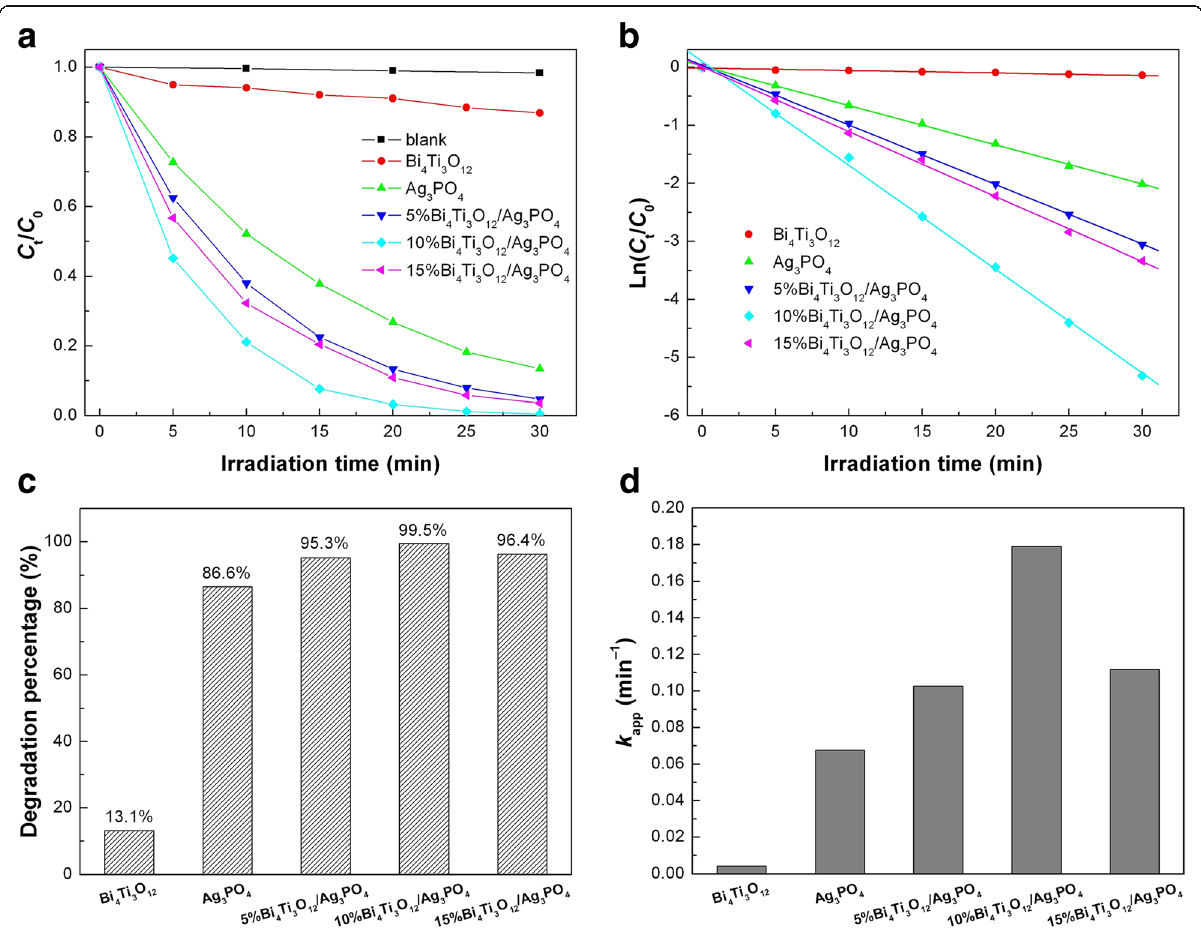
Fig. 9 a Time-dependent photocatalytic degradation of RhB over Bi 4 Ti 3 O 12 , Ag 3 PO 4 , and Bi 4 Ti 3 O 12 /Ag 3 PO 4 composites. b Plots of Ln( C t / C 0 ) versus irradiation time t for the samples. c Degradation percentages of RhB after 30 min of photocatalysis over the samples. d Apparent first-order reaction rate constants k app for the